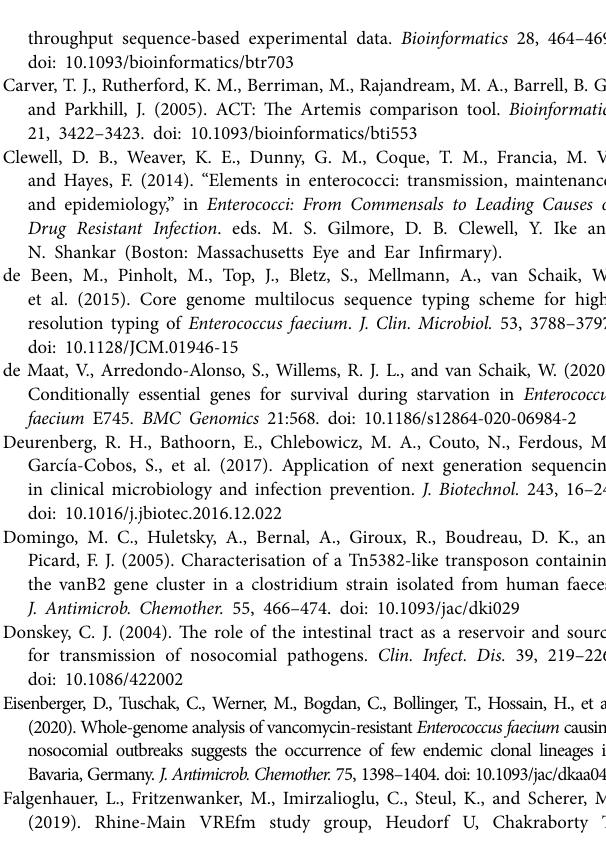
Supplementary Table 4 | Summary of the putative phages identified in this study. The presence and absence of the phages have been indicated with 1 and 0, respectively. The output generated by PHASTER is ordered according to the phage ID reported in the study. Supplementary Table 5 | mlplasmid results of the hybrid assemblies A12 and B11. The predicted plasmid contigs have been renamed in ascending order. Detailed information concerning the RIP families and relaxase protein is herewith